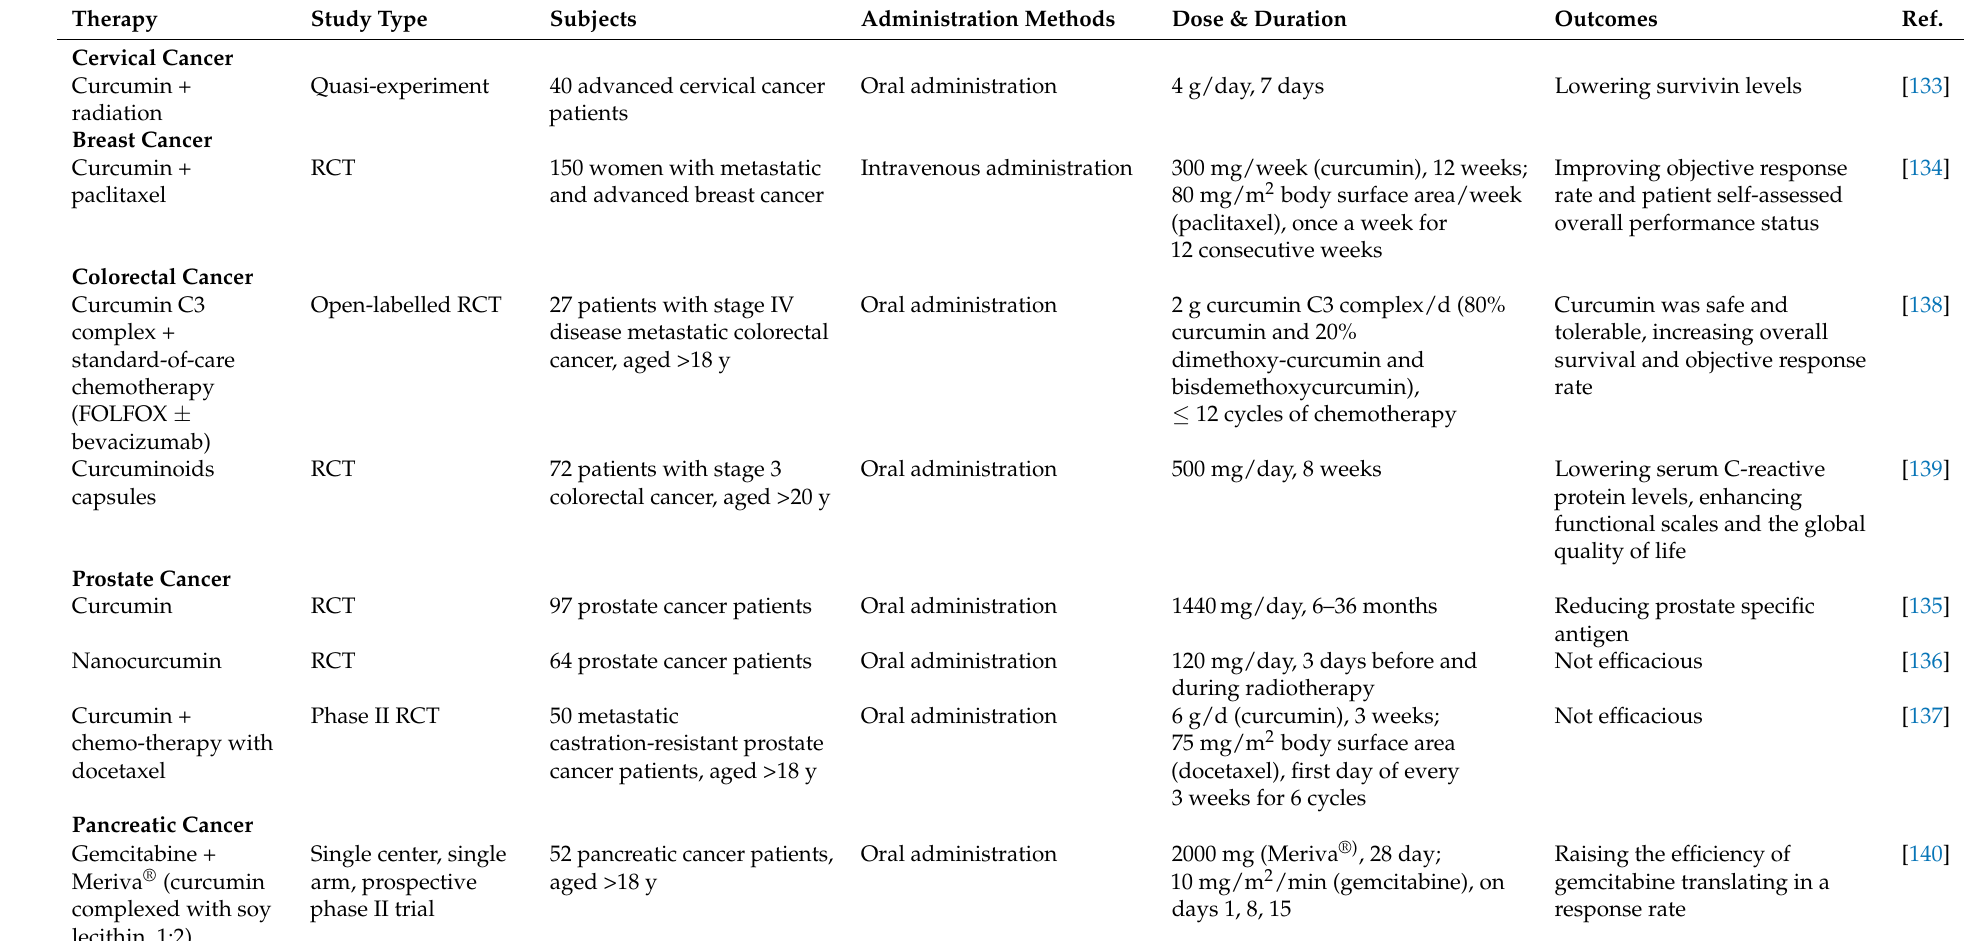
Table 2. The effects of curcumin on cancers from clinical